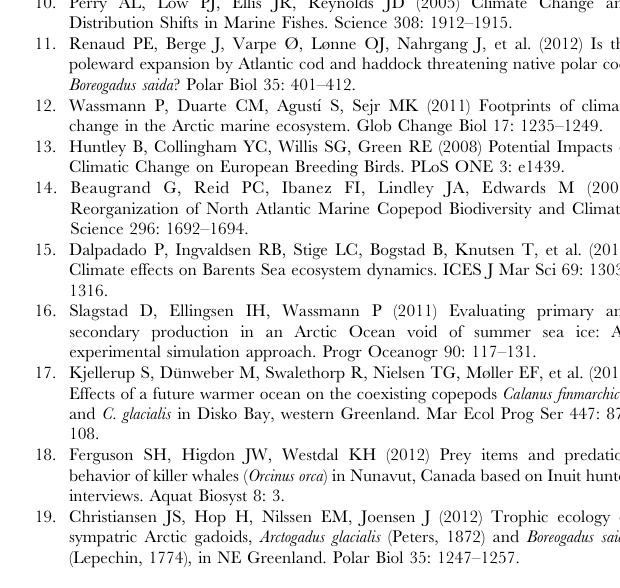
Figure S2 Relationship between total length (cm) and fork length (cm) of polar cod (n= 1463). Data includes specimens from November 2010 (Isf), September 2011 (Hin), January 2011 (Adv, Isf, Bell), April 2012 (Adv) and September 2012 (Bill, Hin, Kong, Rijp). Figure S3 Example of polar cod population size struc- ture in January 2012 and January and September 2013. Arctic domain Rijpfjorden (black continuous line) and Hinlopen (dot-dashed, Sept 2013) and in the Atlantic domain Adventfjorden (dotted line, in Jan 2012), Isfjorden (dotted line in Sept 2012 and 2013) and Kongsfjorden (dashed line). Numbers in brackets indicate total amount of polar cod in each trawl haul. Table S1 Overview of the sampling stations and number of specimens considered for each analyses. Fish , 10 cm in length were excluded, except for the population structure data (Table 1). Number of specimens between analyses can differ due to lack of adequate information for some specimens. For instance, January 2012 Rijpfjorden, otoliths were available for 73 specimens (Fig 3), but GSI was only present for 66 specimens (Table 2 and Fig 5). Table S2 Hepatosomatic index (HSI%, mean ± SD) of polar cod. Immature (I) and mature (M) polar cod were collected in January 2011, 2012 and 2013, from the Arctic (162) and Atlantic (104) domains. Numbers in bold and italics are significant differences (T-test) in means between immature and mature polar cod for a domain and size class (cm). Table S3 Histological analysis of gonads of mature polar cod from January 2011 (Isfjorden) and 2012 (Rijpfjorden). The Table shows mean occurrence of oocyte stages (%) based on oocyte counts (n =254 oocyte counts), mean diameter (mm) and weight (ug) of each oocyte stage: oogonia (Oo), previtellogenesis (PVit), cortical alveoli (CA), lipid inclusions formation (LIF), vitellogenesis (Vit), maturation (Mat), post- ovulatory follicles (POF), atretic oocytes (AO). There were no